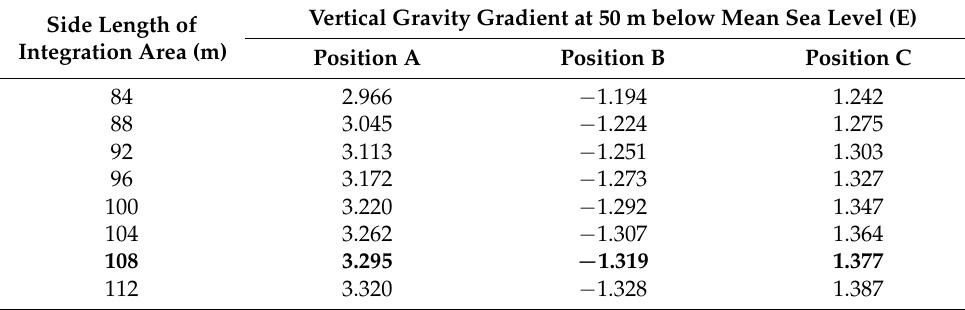
Table 4. Variation of gradient with integration range at 50 m below mean sea level. Side Length